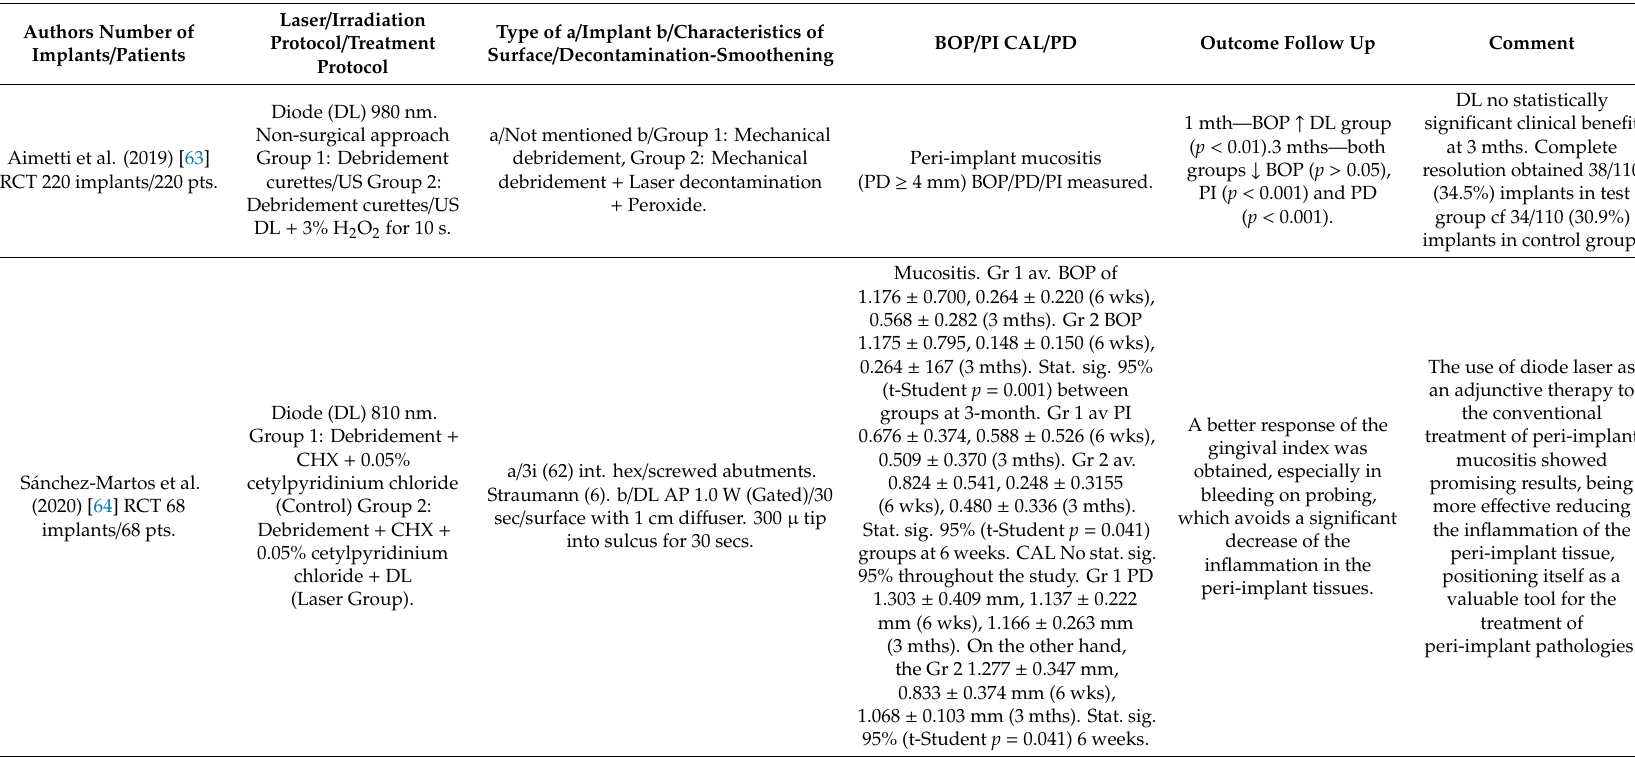
Table 1. Analysis of peri-implant